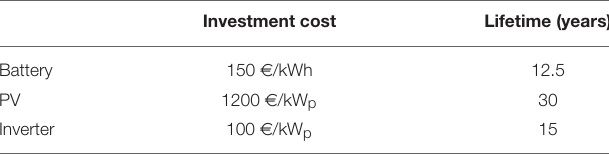
TABLE 2 | Costs and lifetime assumptions for residential PV-battery system investments, as obtained from Goop et al. (submitted).